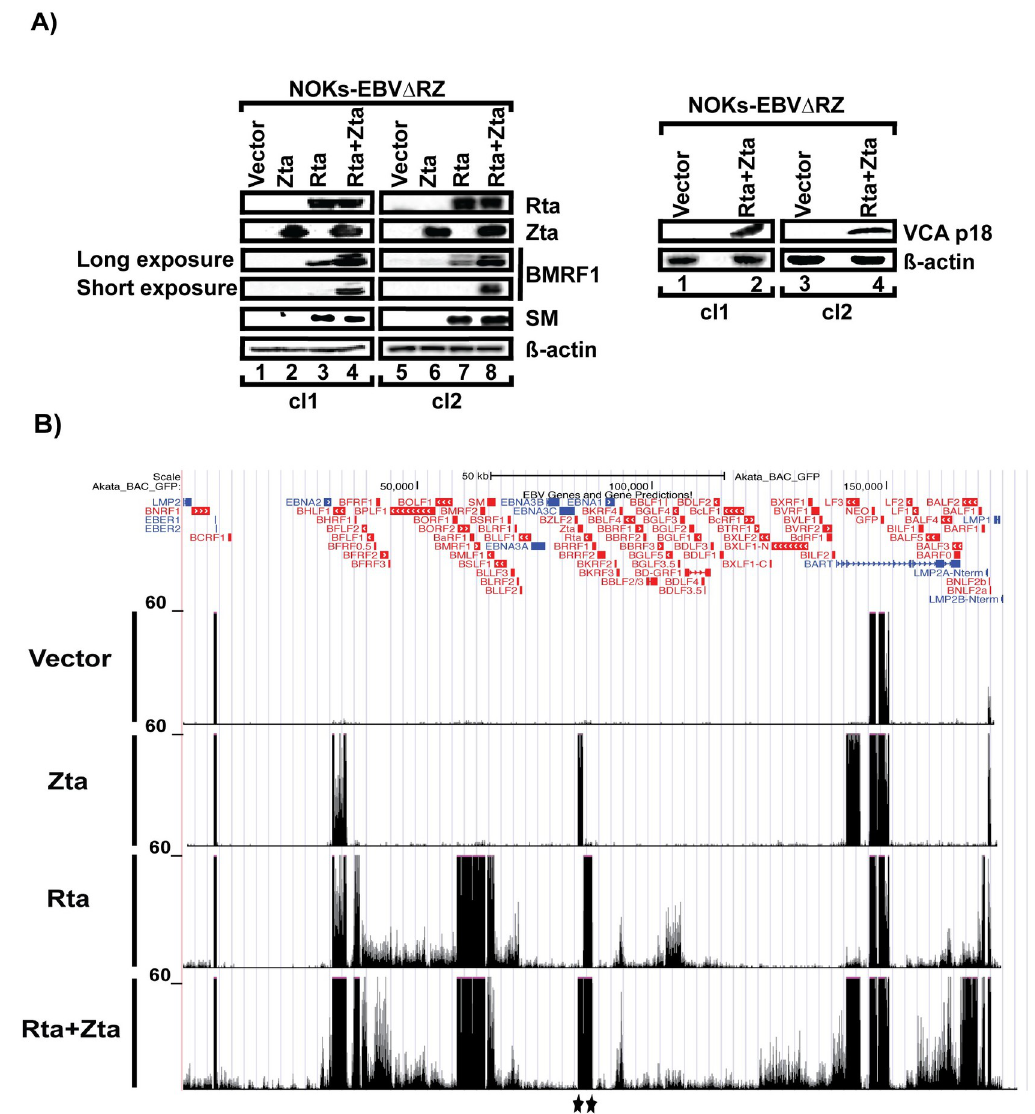
Fig 3. Rta and Zta dependence of EBV lytic gene expression in NOKs. (A) Western blots showing the specified EBV or cell proteins from NOKs-EBV Δ RZ cells transfected with either Zta, Rta, Rta+Zta, or vector-only. The data are representative of two independent experiments. The data are from two different NOKs-EBV Δ RZ clones and representative of two independent biologic replicates. (B) UCSC genome browser images displaying RNA-seq data mapped to the EBV Akata_BAC_GFP genome. Trans-complemented proteins are indicated to the left of each track and correspond to those used in (A). Black stars indicate reads arising from transfected Rta and/or Zta.